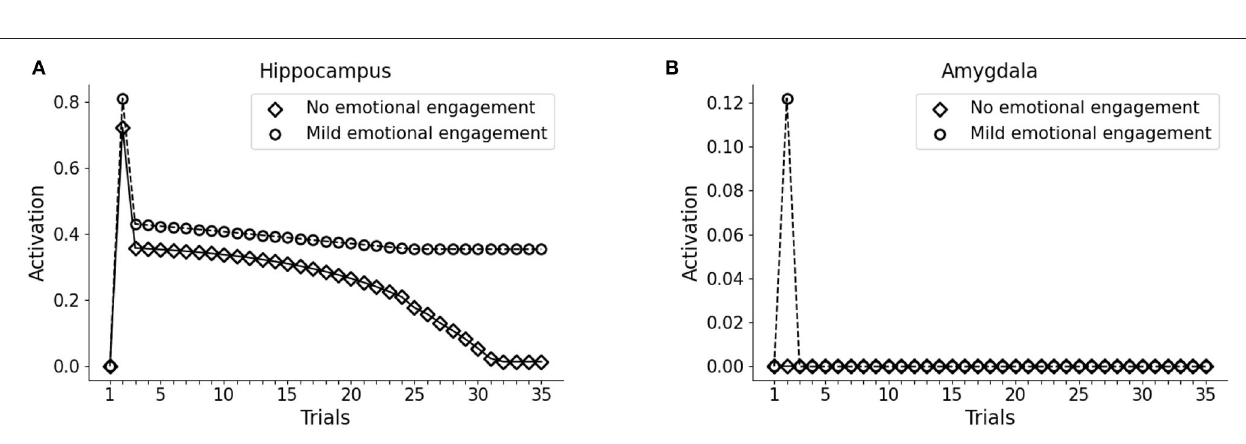
FIGURE 5 | Effect a mild emotional engagement on memory retention. Hippocampus (A) and amygdala (B) activity with an activation protocol as in Figure 2 , except that the vmPFC firing threshold is halved (model robust with respect to PTSD) and that during the second trial the emotional (Trauma) unit is weakly activated (1/10 of activation) to represent a mild (non-traumatic) emotional engagement of the